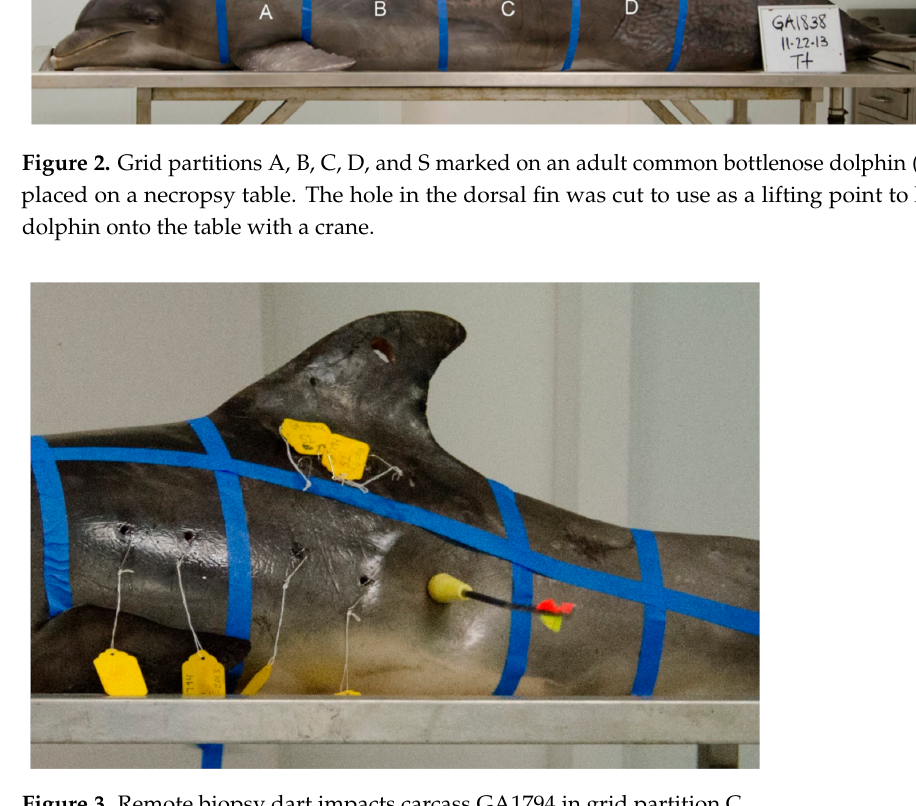
Figure 3. Remote biopsy dart impacts carcass GA1794 in grid partition